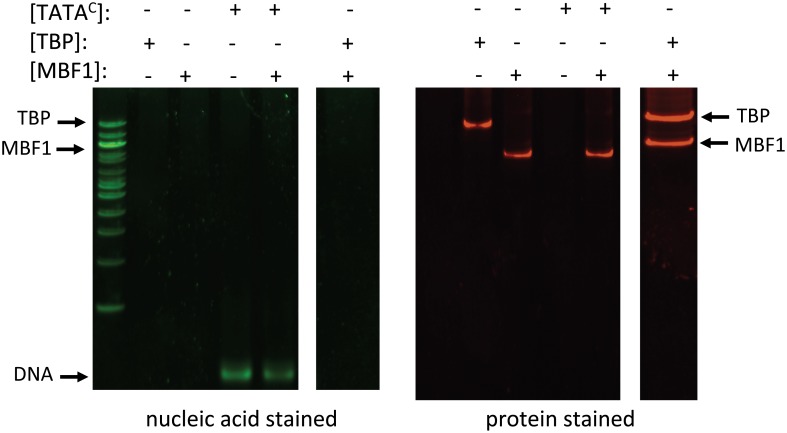
Control EMSA experiments containing indicated proteins in reaction mixtures.Concentrations of TATAC = 18.3 nM, TBP = 1129 nM, and MBF1 = 855 nM. Left panels visualized with nucleic acid stain (green), right panels, protein stain (red).